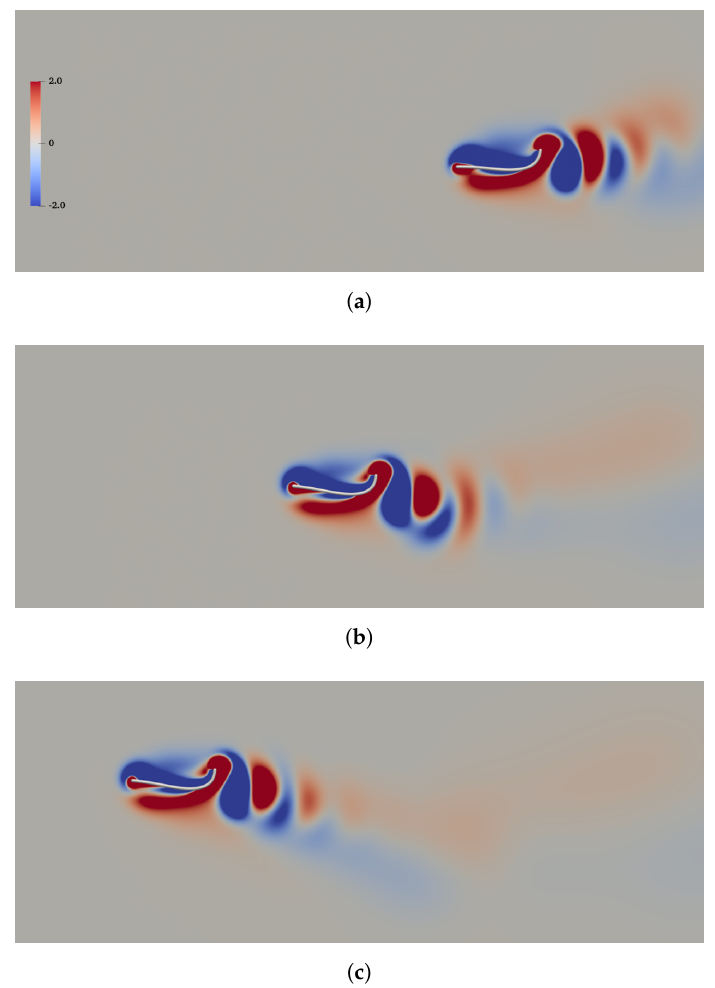
Figure 19. Vorticity contours at 5 T ( a ), 8 T ( b ) and 14 T ( c ) in the turning maneuver with θ max = − 6 ◦